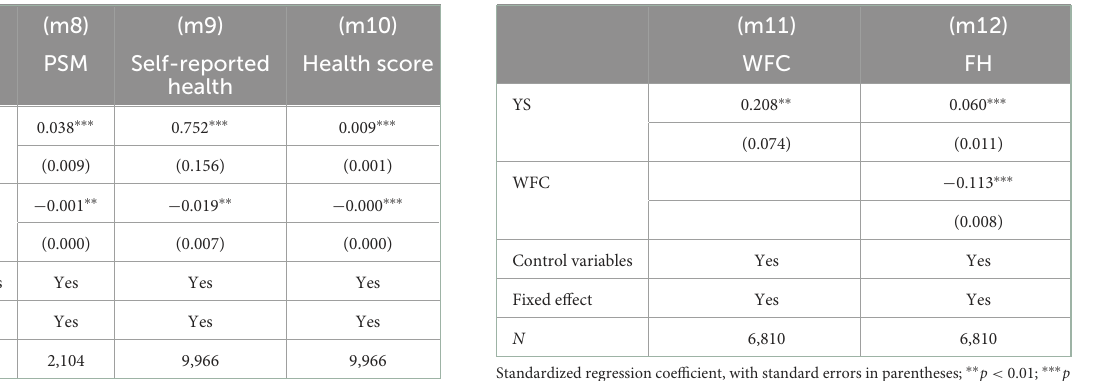
TABLE 5 Effects of YS on HF, self-reported health, and health score. TABLE 6 The link between YS, WFH, and